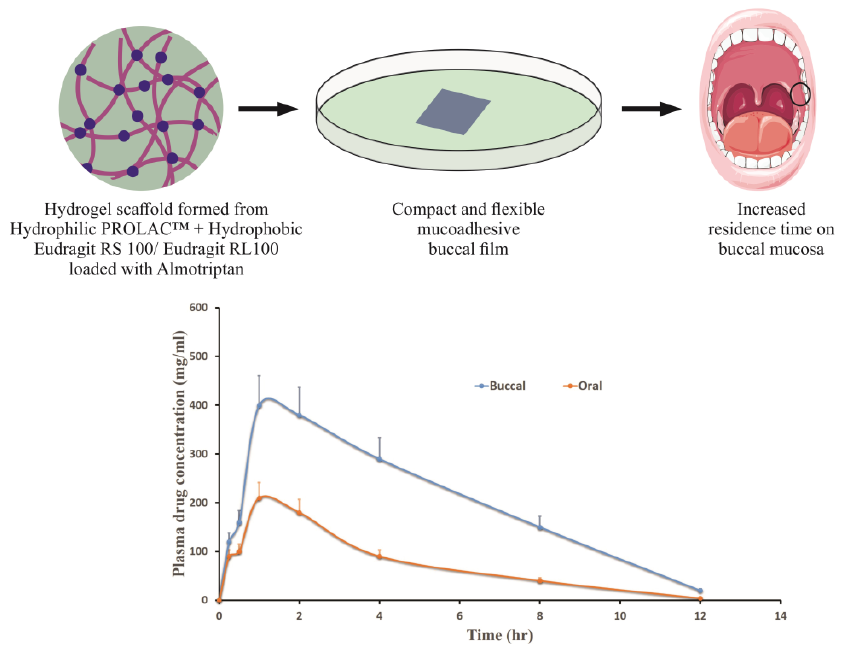
Figure 4. Enhanced buccal permeation demonstrated by the hydrogel-based mucoadhesive almotrip- tan buccal film compared to oral suspension containing equivalent dose